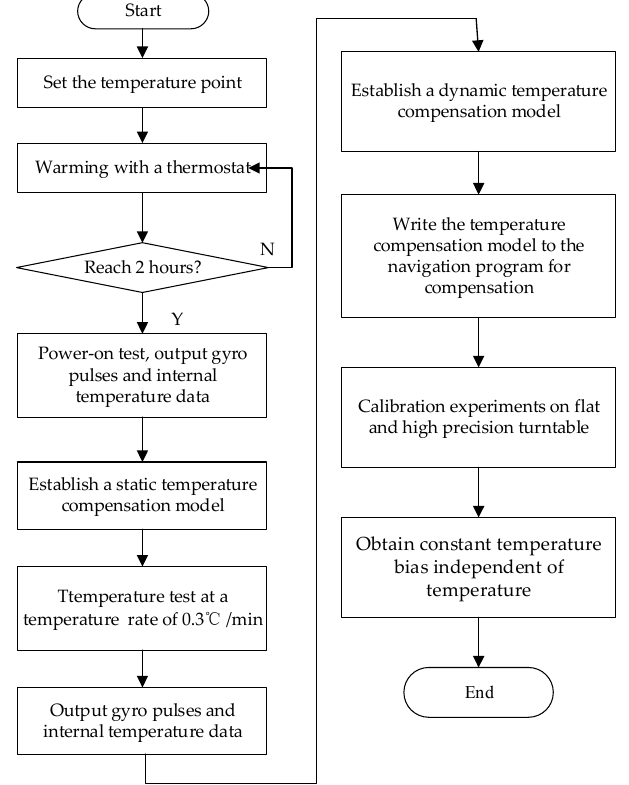
Figure 2. The ring laser gyroscope (RLG) temperature calibration flow chart.